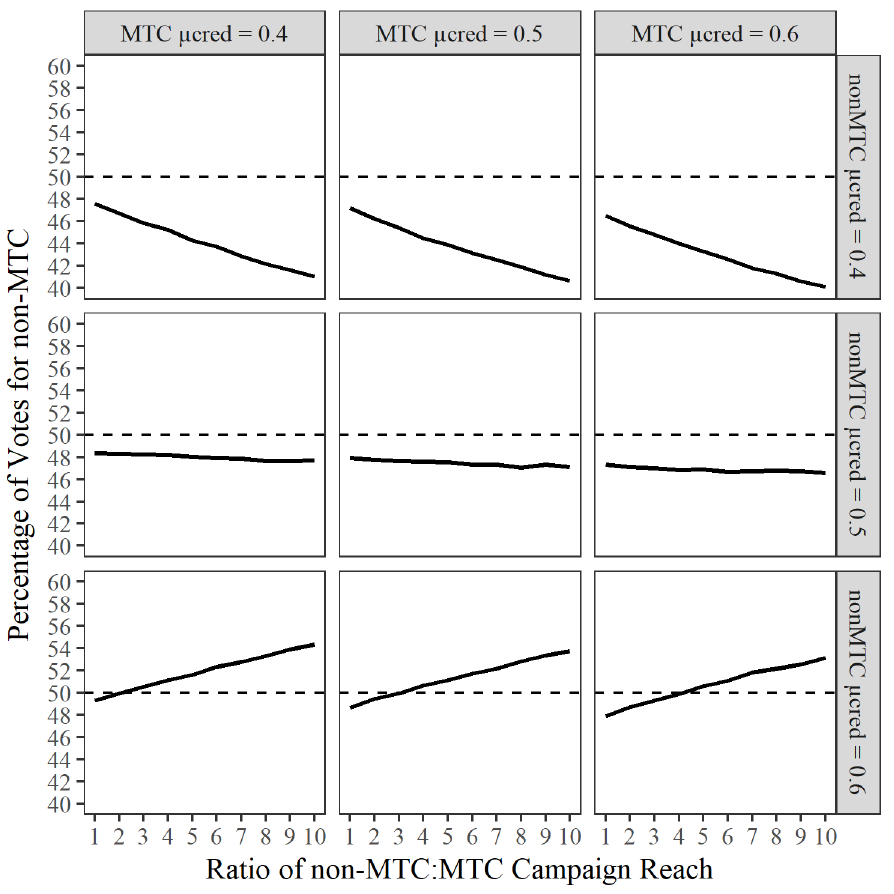
Fig 3. Voting outcome of simulated election campaigns. a Dashed line represents break-even point between candidate vote shares.